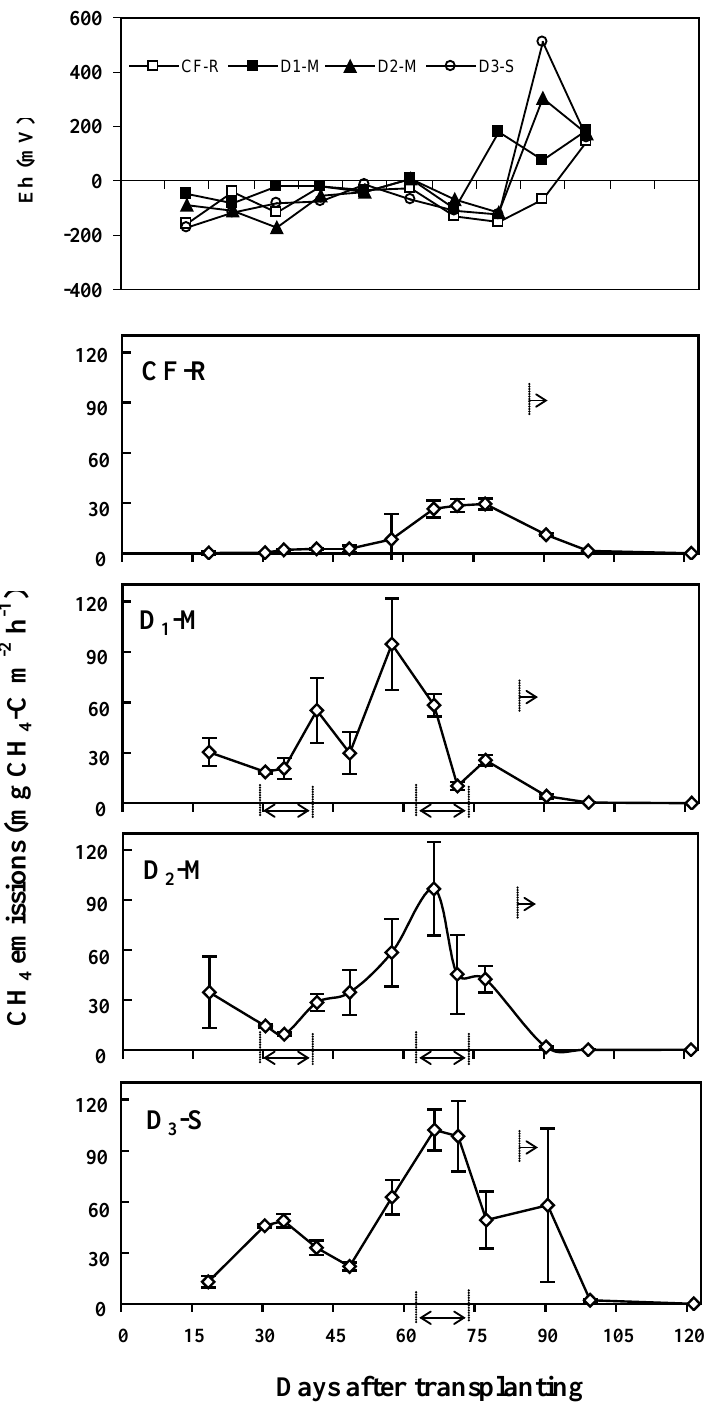
Figure 4. The CH 4 emissions over time and Eh measured from paddy fields during the growing season. Error bar indicating standard deviation. ↔ = Drainage period. → = Final drainage for harvest.